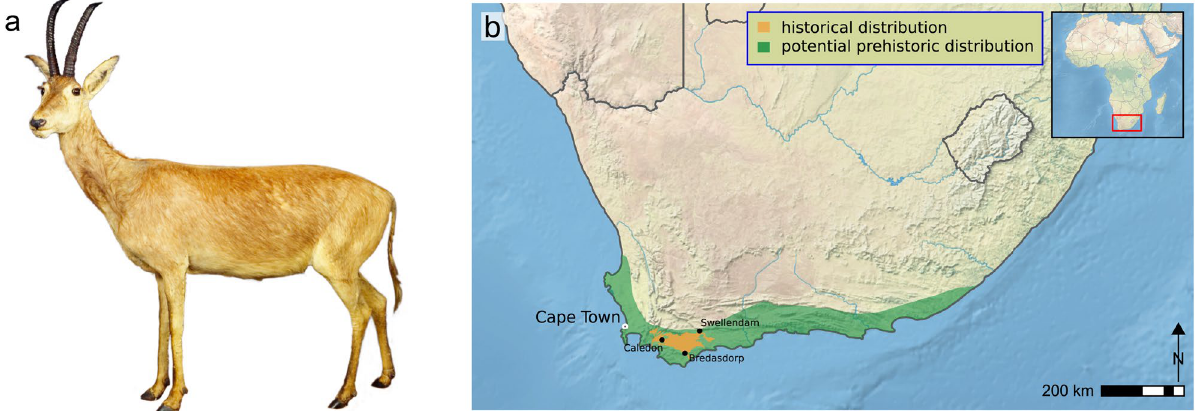
Figure 1. The blue antelope and its historical and potential prehistoric distribution. ( a ) The only known mounted female specimen of the blue antelope ( Hippotragus leucophaeus ) (Natural History Museum Vienna, NMW ST 715); the characteristic white patch in front of the eyes is clearly visible (photo credit: Natural History Museum Vienna). ( b ) Historical and potential prehistoric distribution of the blue antelope (drawn in Inkscape v0.91 (https ://inksc ape.org) from Kerley et al. 16 and Faith & Thompson 6 ; base map: https ://www.natur alear thdat a.com